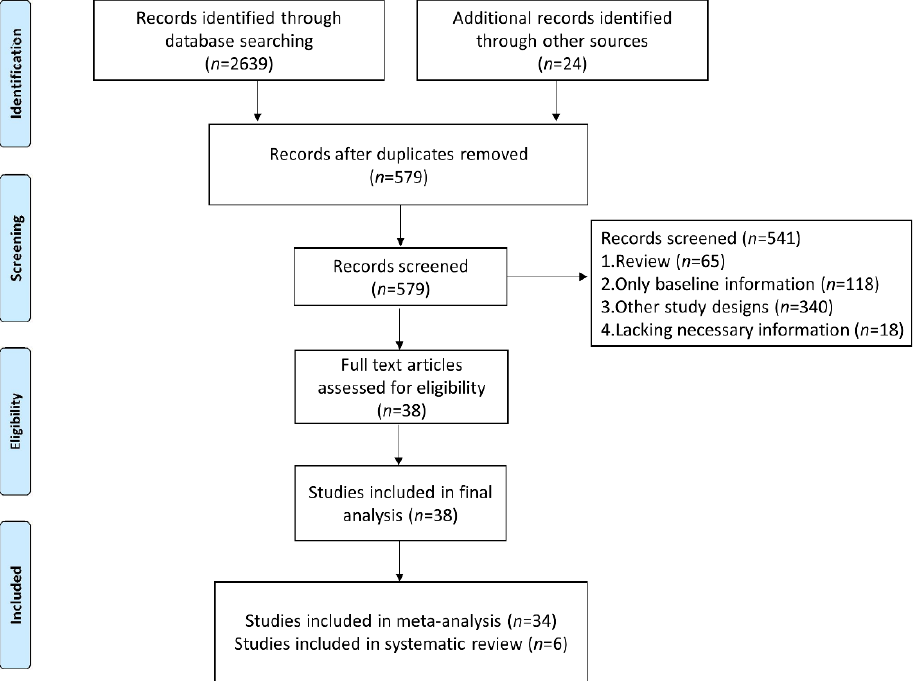
Figure 1. Flow diagram of study selection for inclusion in this meta-analysis and systematic review.